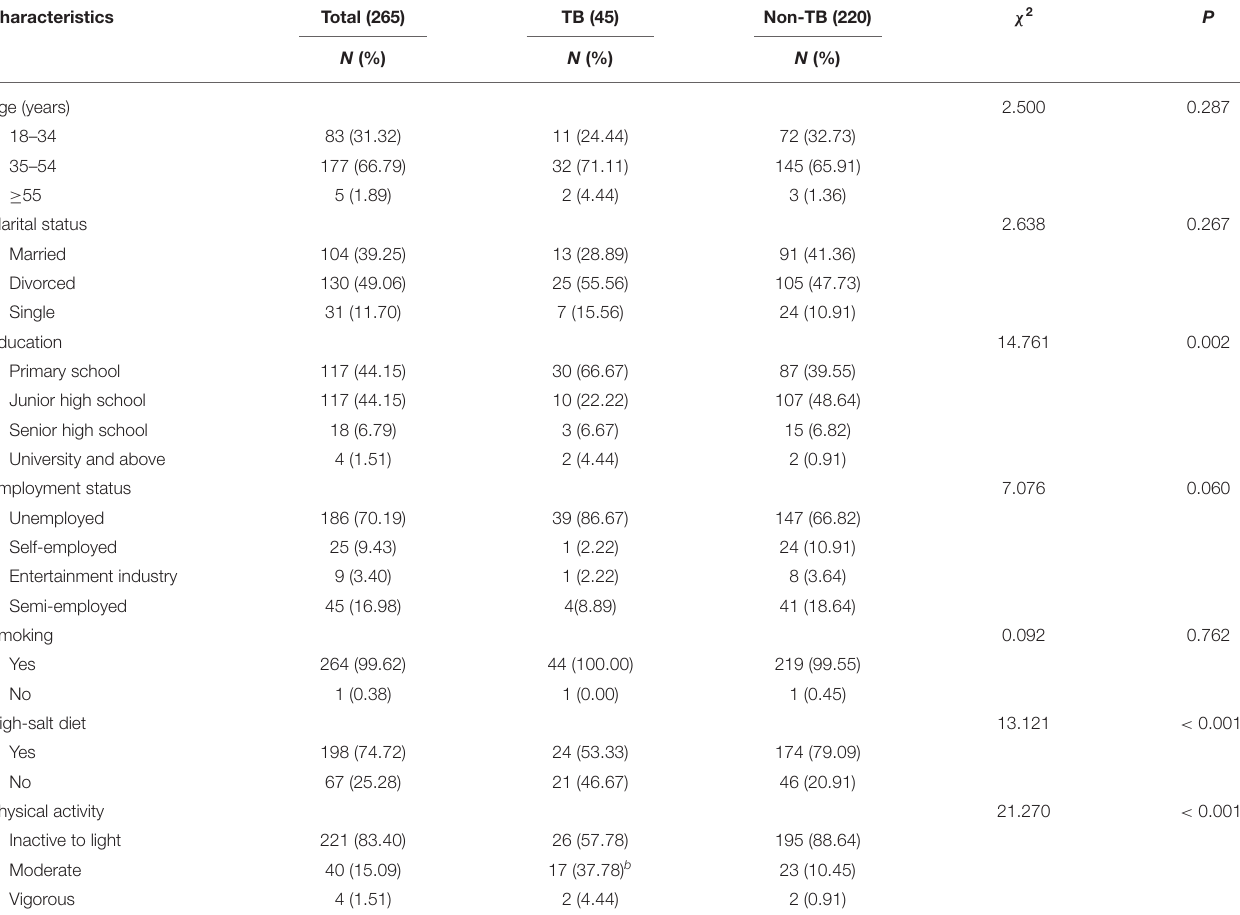
TABLE 1 | Demographics of the study